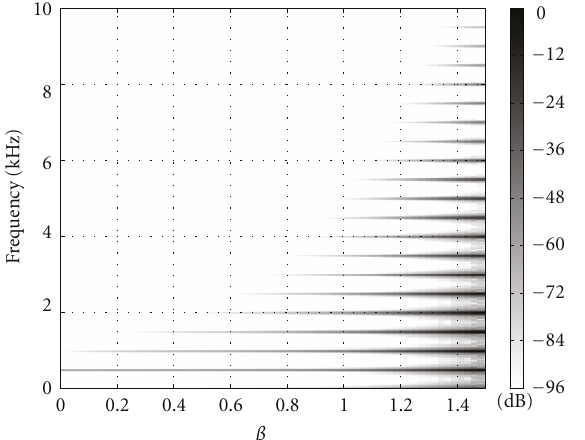
Figure 6: Spectrogram of the FBAM output with β varying from 0 to 1.5 ( f 0 = 500Hz).